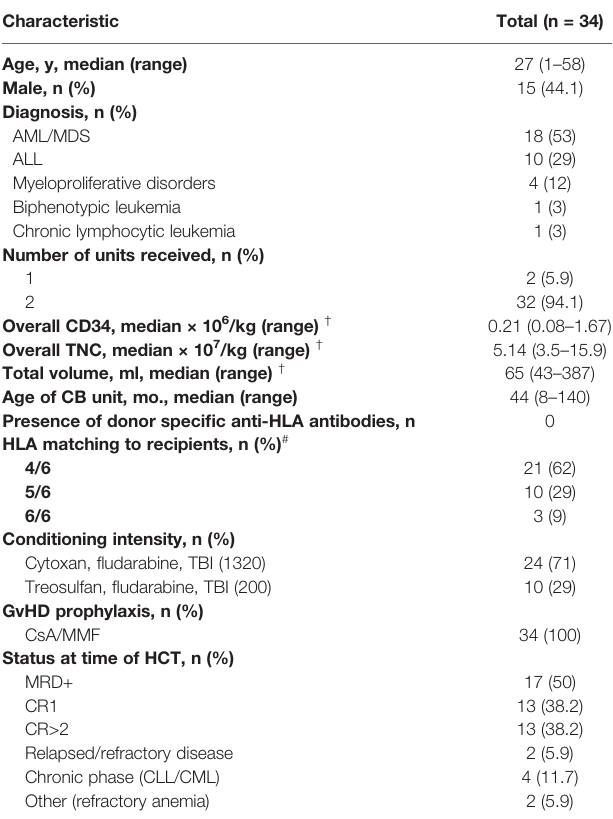
TABLE 1 | Patient and unit characteristics of 34 cord blood transplantation (CBT)